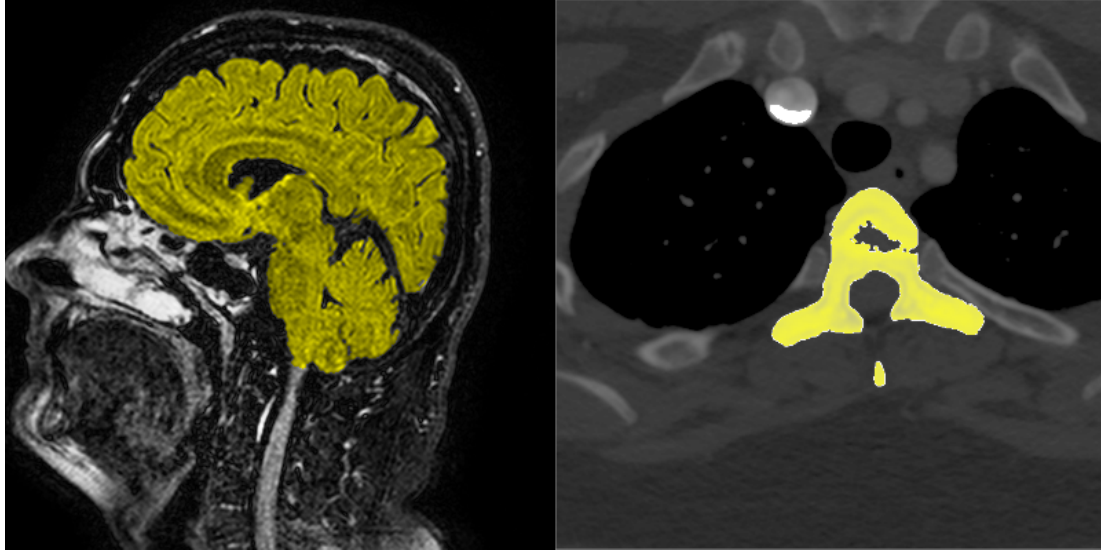
Figure 1. Example of MRI sagittal brain scan slice ( left ) and CT transversal thoracic scan slice ( right )—tissue segmented with our system is highlighted in